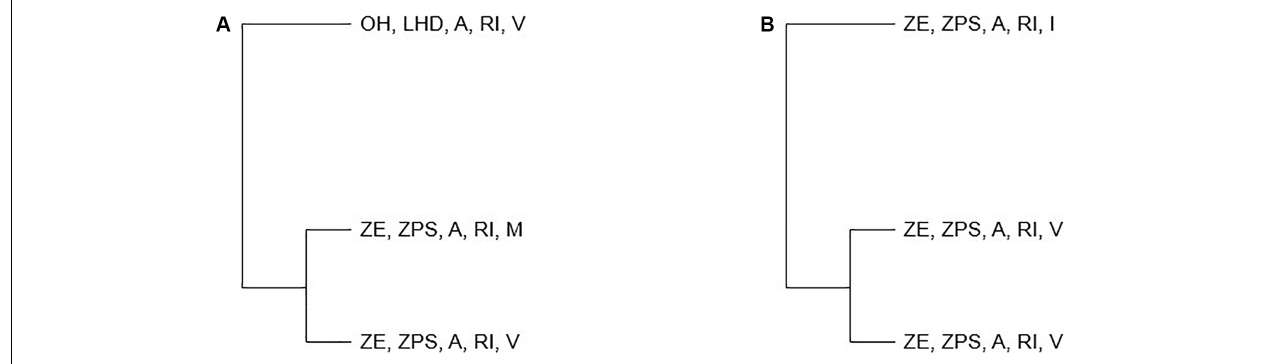
FIGURE 7 | Marro360 ◦ strategic chains used by the two teams in the role of Hunter.